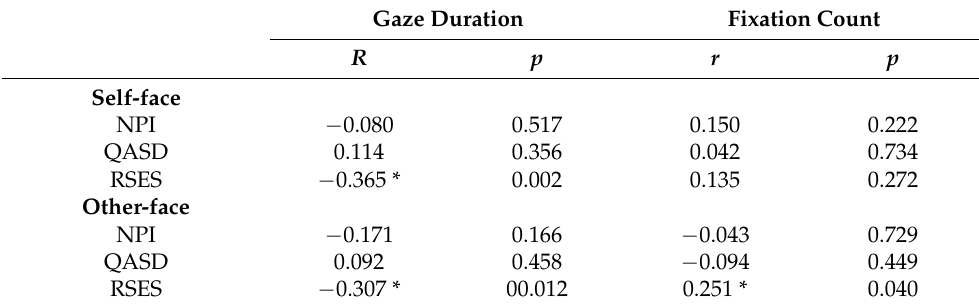
Table 1. Pearson correlations between gaze duration and personality traits.